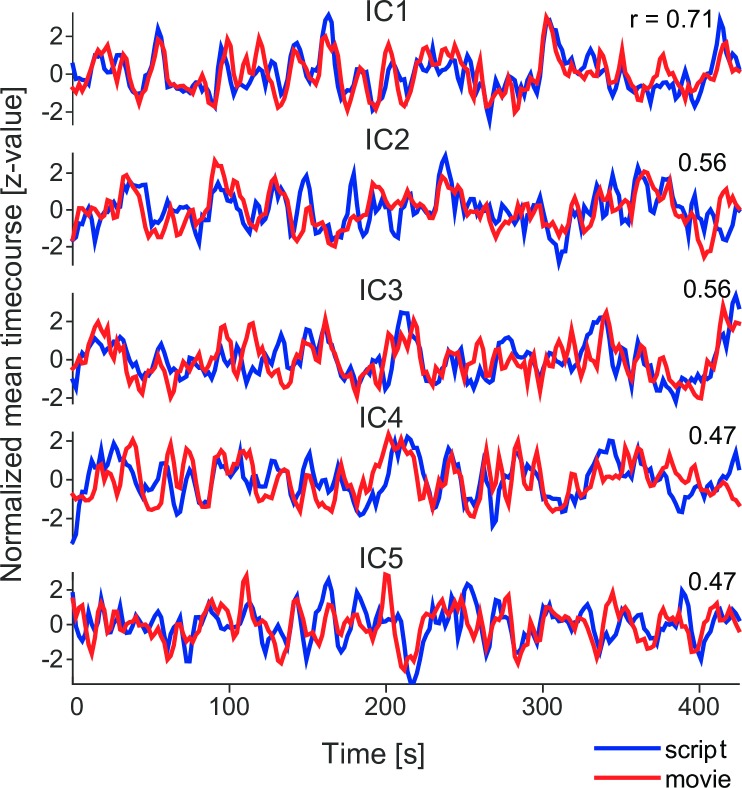
Time-courses of TOP-5.Normalized mean time-courses of TOP-5 ICs arranged from IC1 (top row; correlation 0.71) to IC5 (bottom row; correlation 0.47) featuring the highest cross-correlations of the time-course between movie (red) and script (blue) narrative presentation forms.